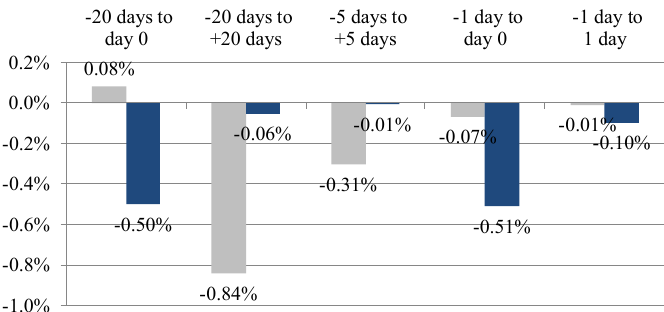
Fig. 4 -Values of the median and the mean (%) for the sample of cumulative abnormal returns in selected time windows (measured in days). Source: Own